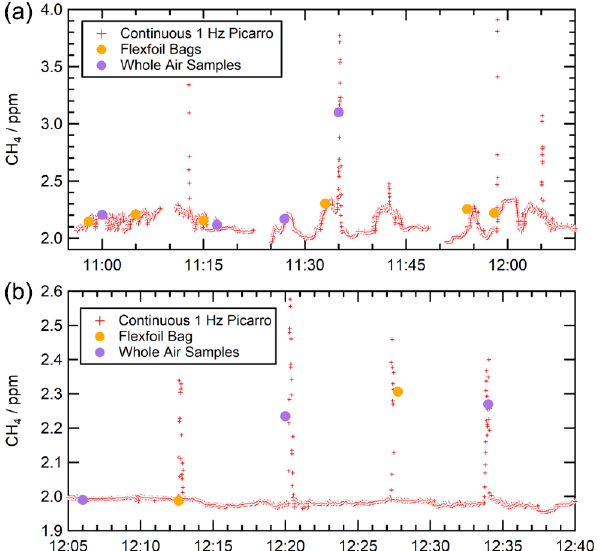
Figure A3. Examples from a 2018 flight (a) and a 2019 flight (b) with attempted capture of CH 4 plumes in spot samples (both SWAS and FlexFoil bags). Note the improved ability to sample at the correct period to capture short-lived enhancement in both SWAS and FlexFoil samples for 2019 compared to 2018 thanks to flight planning and SWAS development improvements.